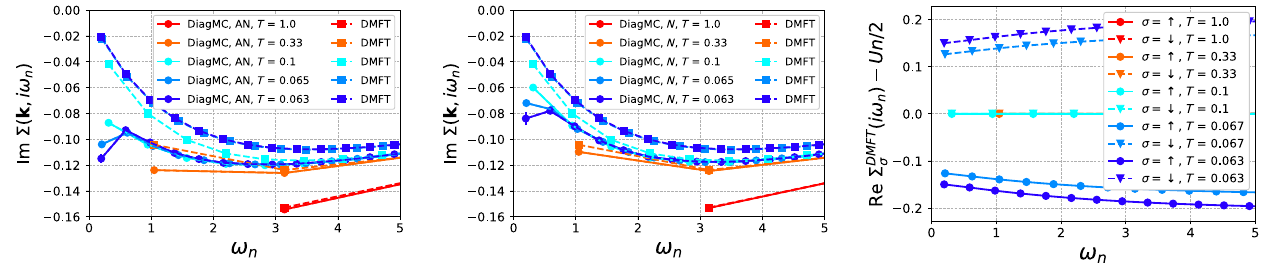
FIG. 4. Left and central panels: imaginary part of the self-energy as a function of frequency at the antinode (left panel) and node (central panel) in DiagMC (circles, solid lines) and the DMFT impurity self-energy (squares, dashed lines) for various temperatures. Right panel: spin-resolved real part of the DMFT self-energy as a function of Matsubara frequency for several temperatures (the Hartree term of Un= 2 ¼ 1 has been subtracted). Note that T DMFT